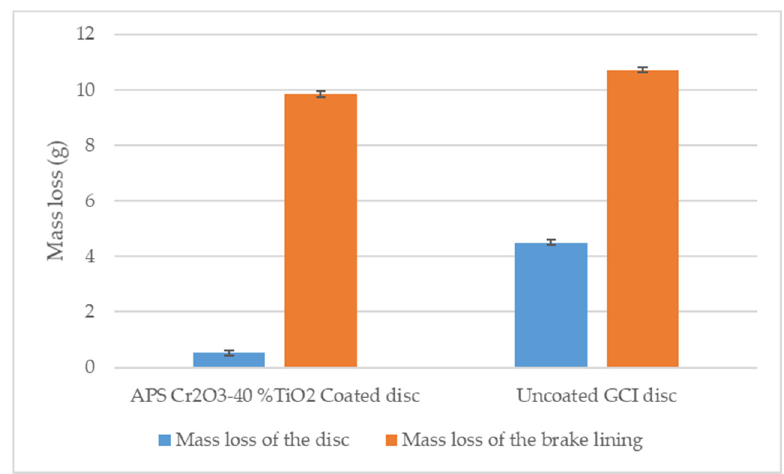
Figure 5. Comparative mass loss of APS Cr 2 O 3 -40%TiO 2 coated and uncoated GCI brake discs and corresponding brake lining mass loss, adopted from Bekir et al.